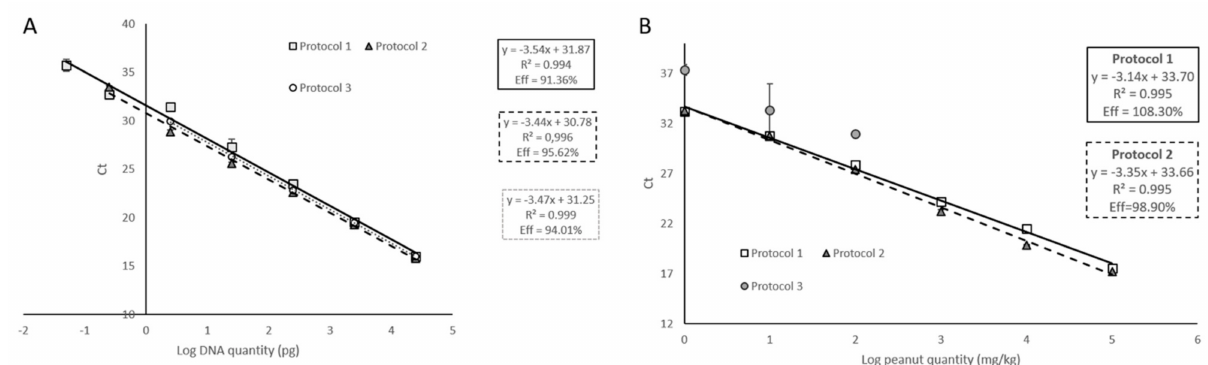
Figure 3. mat K target detection analyzing peanut DNA samples isolated with three different protocols. ( A ) Calibration curves of real-time PCR assay using mat K specific primers and probe, performed with 10-fold serial diluted peanut DNA isolated by three different isolation protocols (1–3); ( B ) calibration curves performed with DNA from binary mixtures of peanut in wheat, using DNA obtained with the three different protocols. Efficiency and R 2 values are included for the two kit-based DNA isolation protocols. Only Ct values obtained after DNA isolation by protocol 3 are shown as grey circles for comparison purposes (samples containing 100, 10, and 1 mg of peanut/kg of mixture). Mean and standard error are represented.